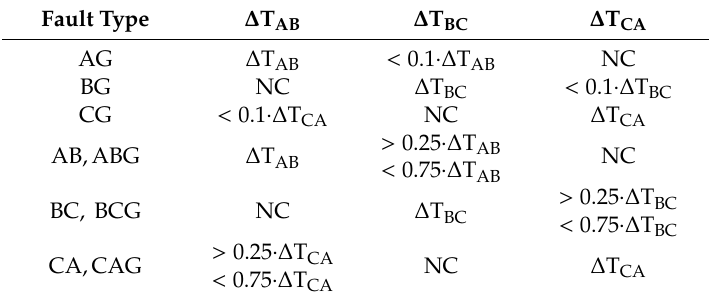
Table 4. New criteria